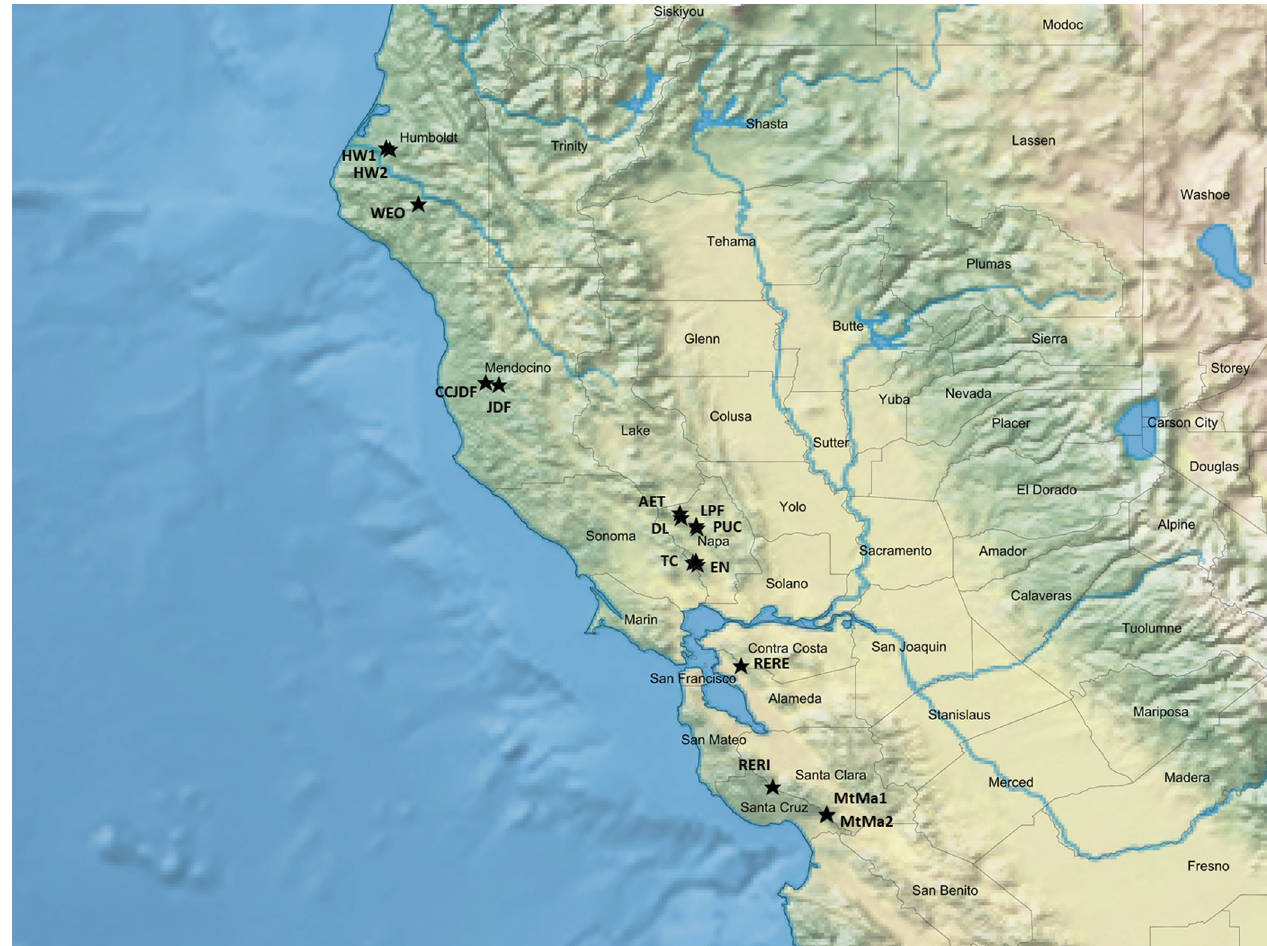
Fig 2. Collection sites for the Californian data set C depicted by stars in the California map generated using the SimpleMappr online software (https:// www.simplemappr.net).